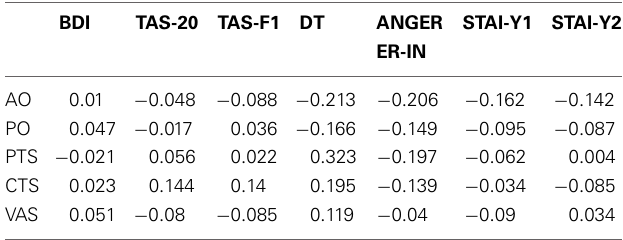
Table 6 | Correlations between clinical and psychological scales